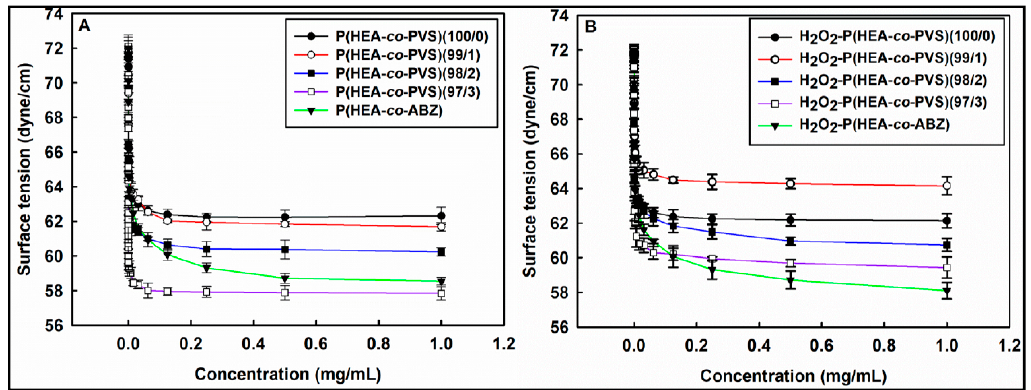
Figure 4. Air/water interfacial tension of copolymer ( A ) and H 2 O 2 -copolymer solutions ( B ). Figure 4. Air / water interfacial tension of copolymer ( A ) and H